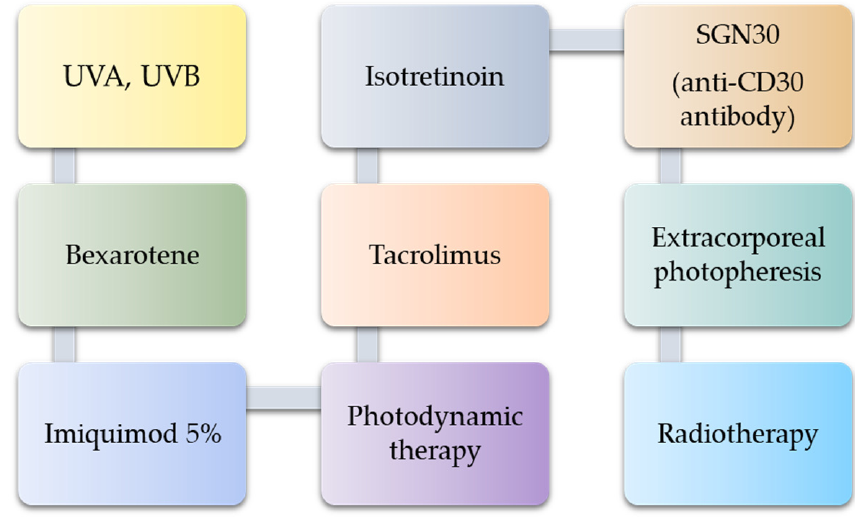
Figure 6. Less-frequent therapeutic strategies for lymphomatoid papulosis treatment.